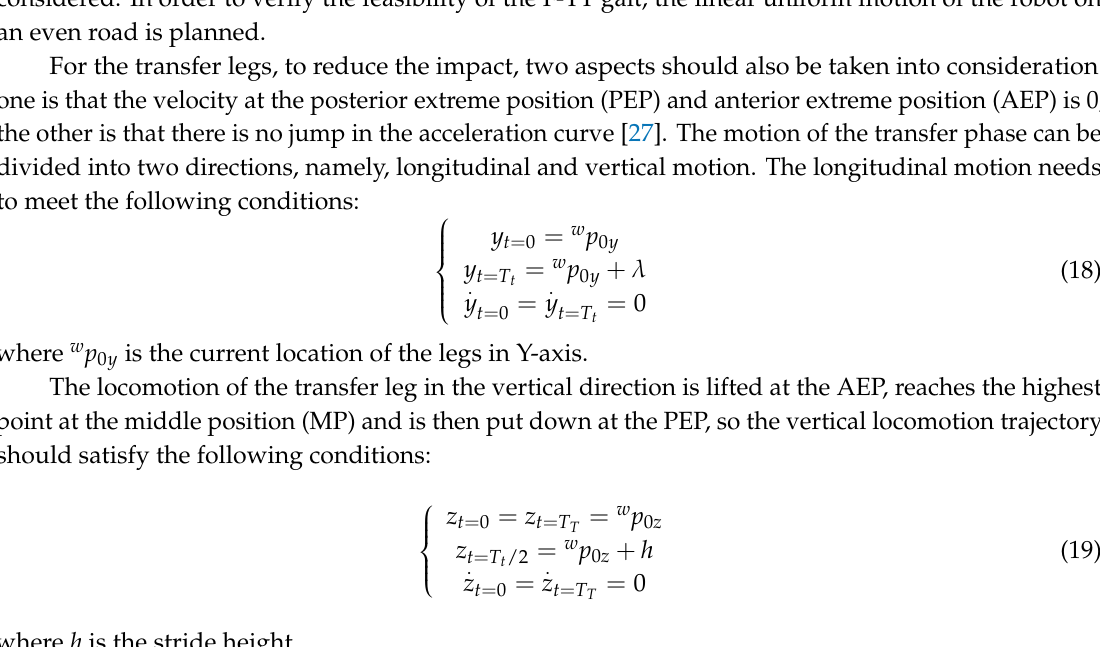
Figure 13. F-TT gait locomotion with coxa initialization angle adjustment in leg 2 fault state.